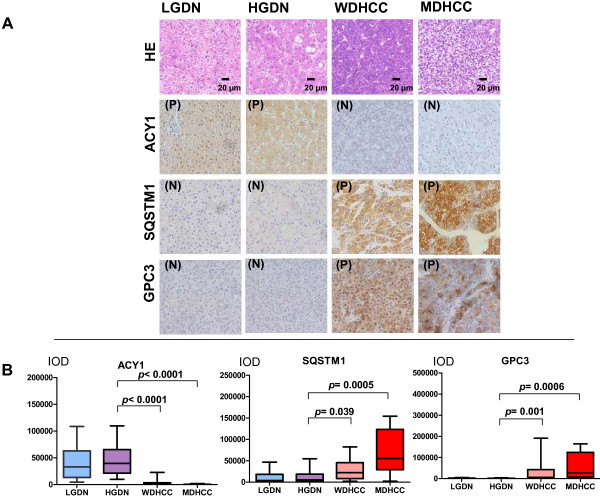
Representative HE-stained sections and immunohistochemical staining for ACY1, SQSTM1, and GPC3 (×200). (A) Typical HE-stained sections and immunostaining for ACY1, SQSTM1, and GPC3 are shown for LGDN, HGDN, WDHCC, and MDHCC. P, positive immunostaining; N, negative immunostaining. (B) Immunohistochemical expression of ACY1, SQSTM1, and GPC3 in LGDN, HGDN, WDHCC, and MDHCC. A box and whisker plot (whiskers: 10–90%) of IOD for each marker was obtained from the tissue microarrays. Mann–Whitney tests showed a significant difference between WDHCC (32 lesions) and MDHCC (19 lesions) compared with HGDN (21 lesions).